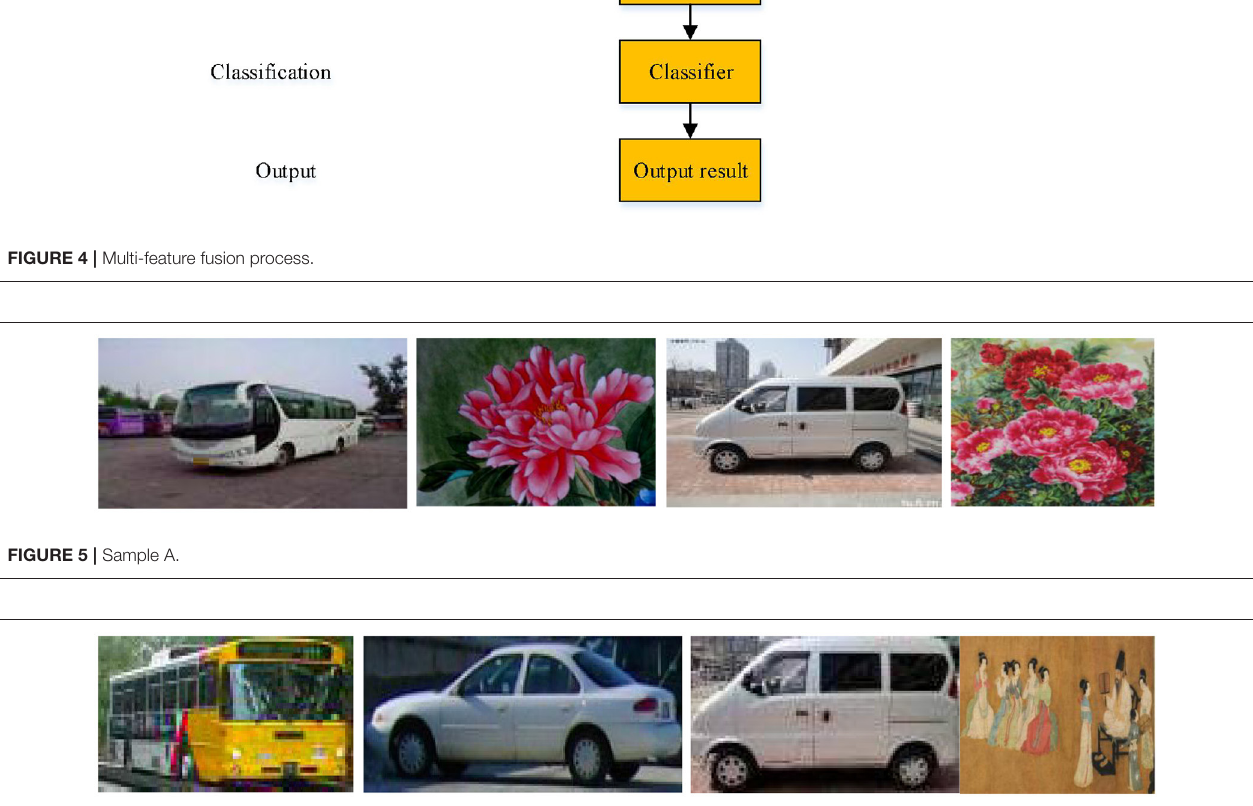
FIGURE 6 | Sample